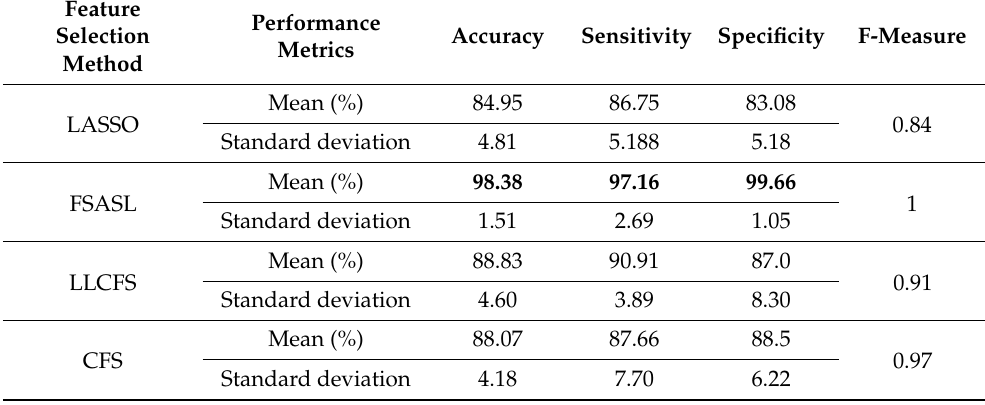
Table 7. Classification performance for MCI against AD using SL-RELM classifier on large scale brain network using different feature selection